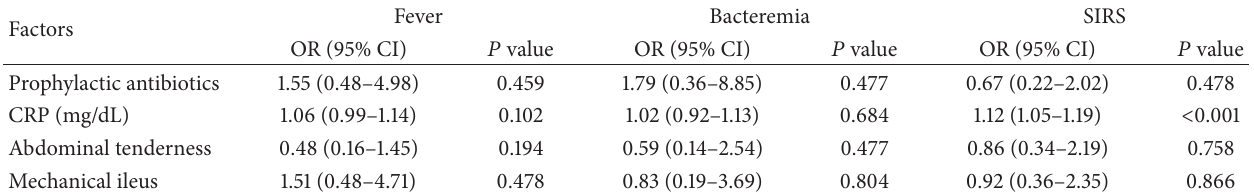
Table 3: Multivariate analysis of factors associated with post-SEMS insertion fever, bacteremia, and SIRS. Factors